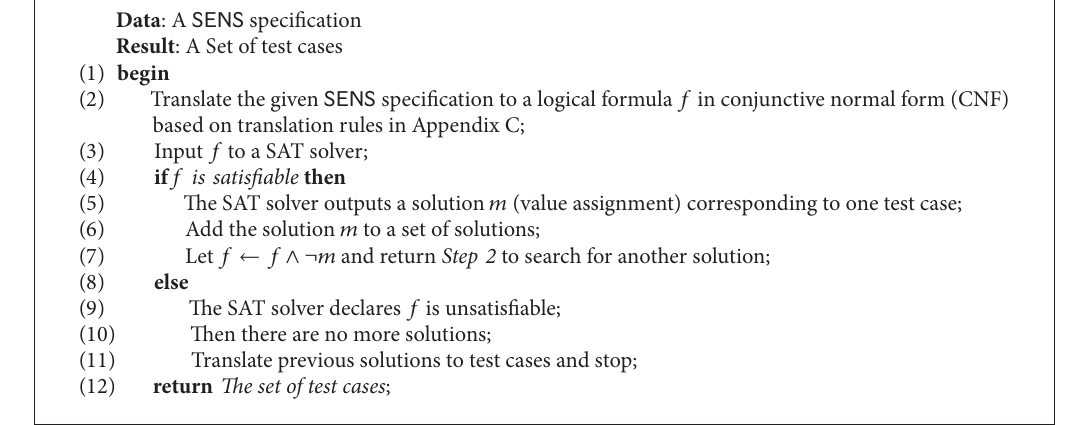
Algorithm 2: Our algorithm of test case